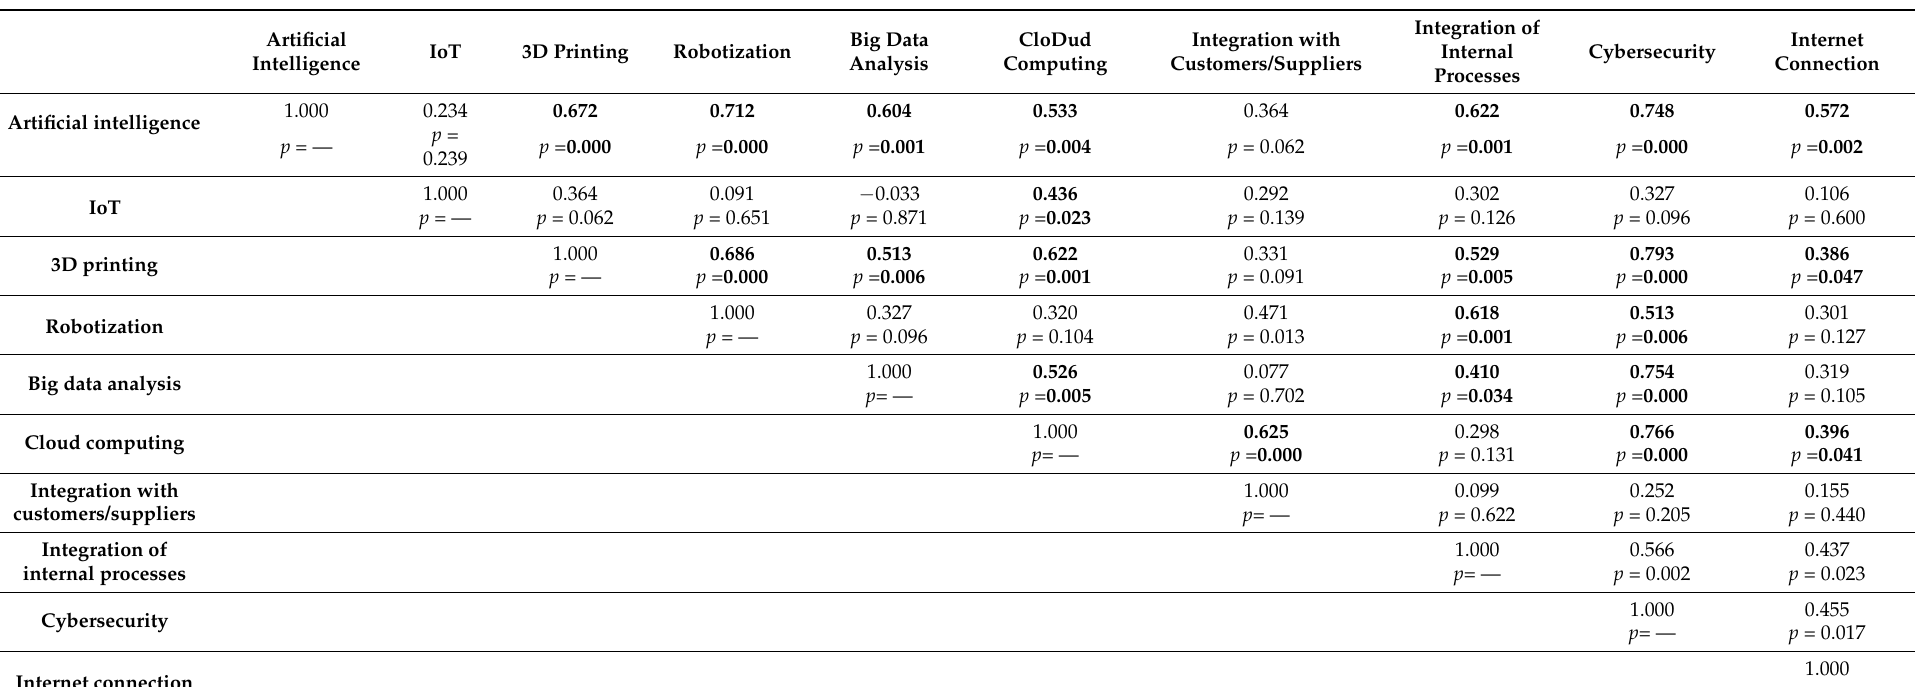
Table 4. Correlation coefficients between the indicators (determinants) adopted for the study (for significance level p <